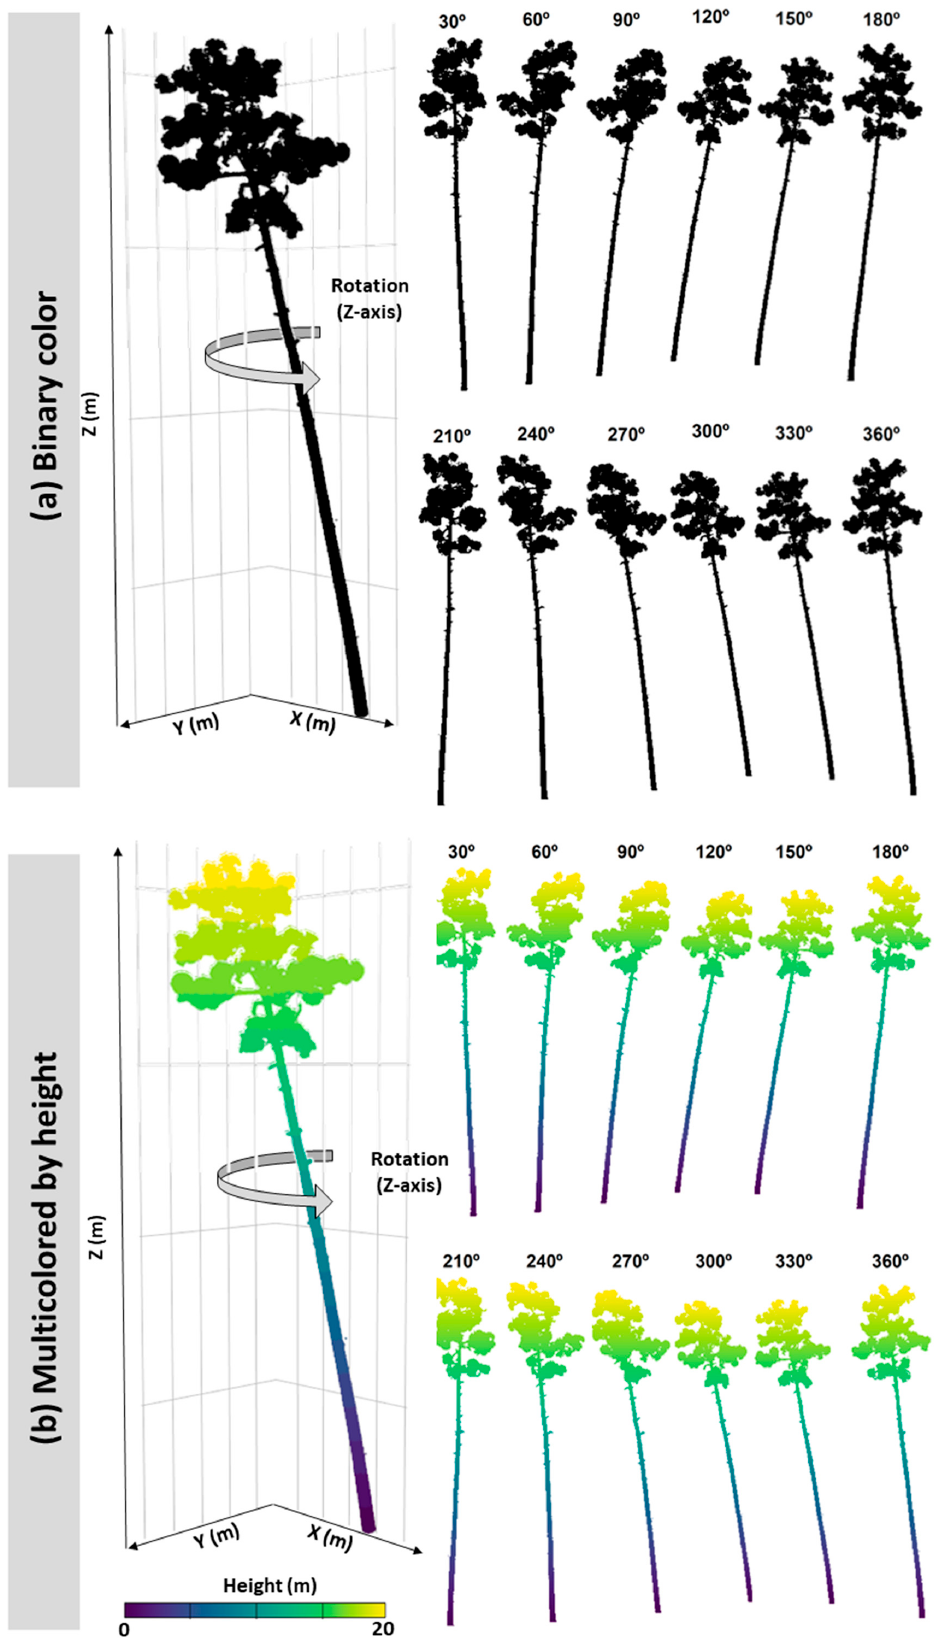
Figure 3. An example of tree-level 3D point cloud rotation (Z-axis by 30 ◦ ) and 2D image computation as ( a , b